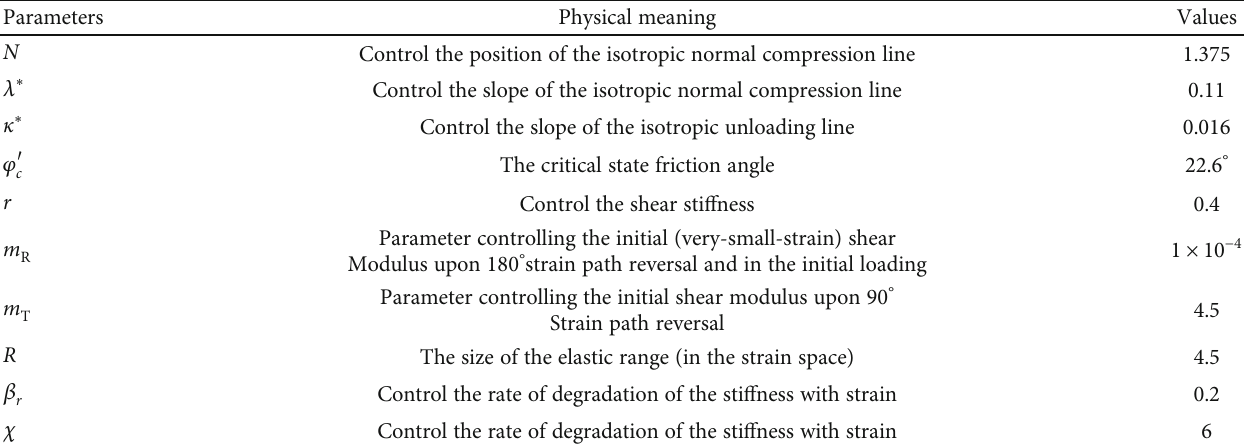
Table 1: Parameters of London Clay in the clay hypoplastic model